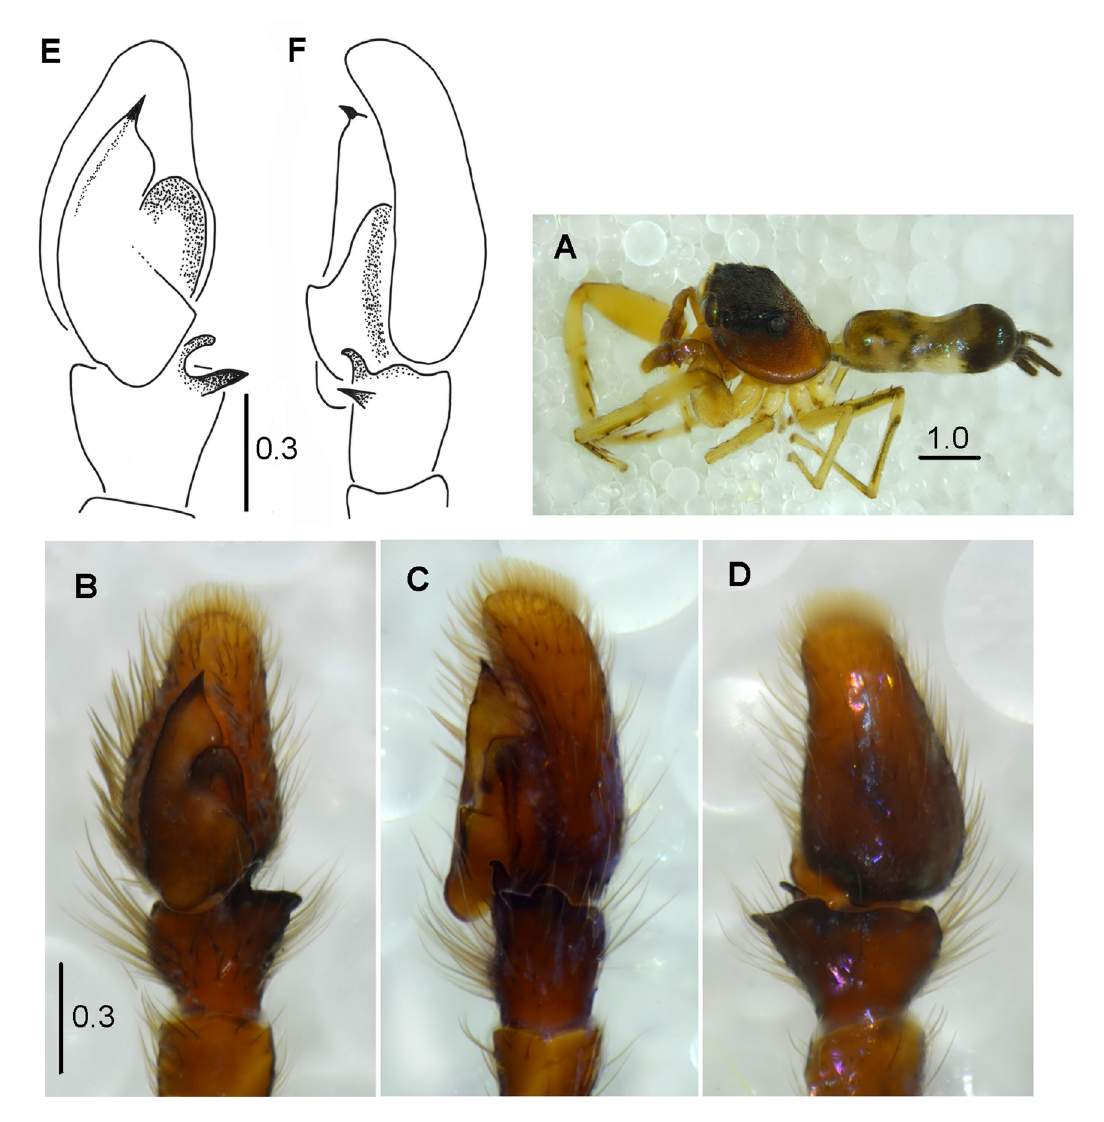
Fig. 41. Orsima constricta Simon, 1901, ♂ (MNHN). A . Habitus of male, lateral view. B, E . Palpal organ, ventral view. C, F . Palpal organ, lateral view. D . Palpal organ, dorsal